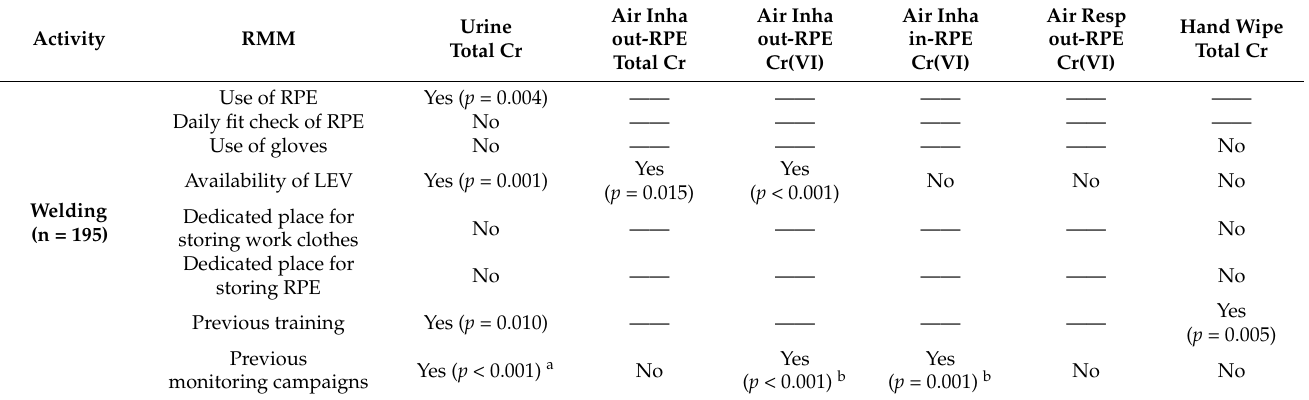
Table 5. Exposure determinants and their effect on workers’ exposure levels (Mann–Whitney test and Kruskal–Wallis